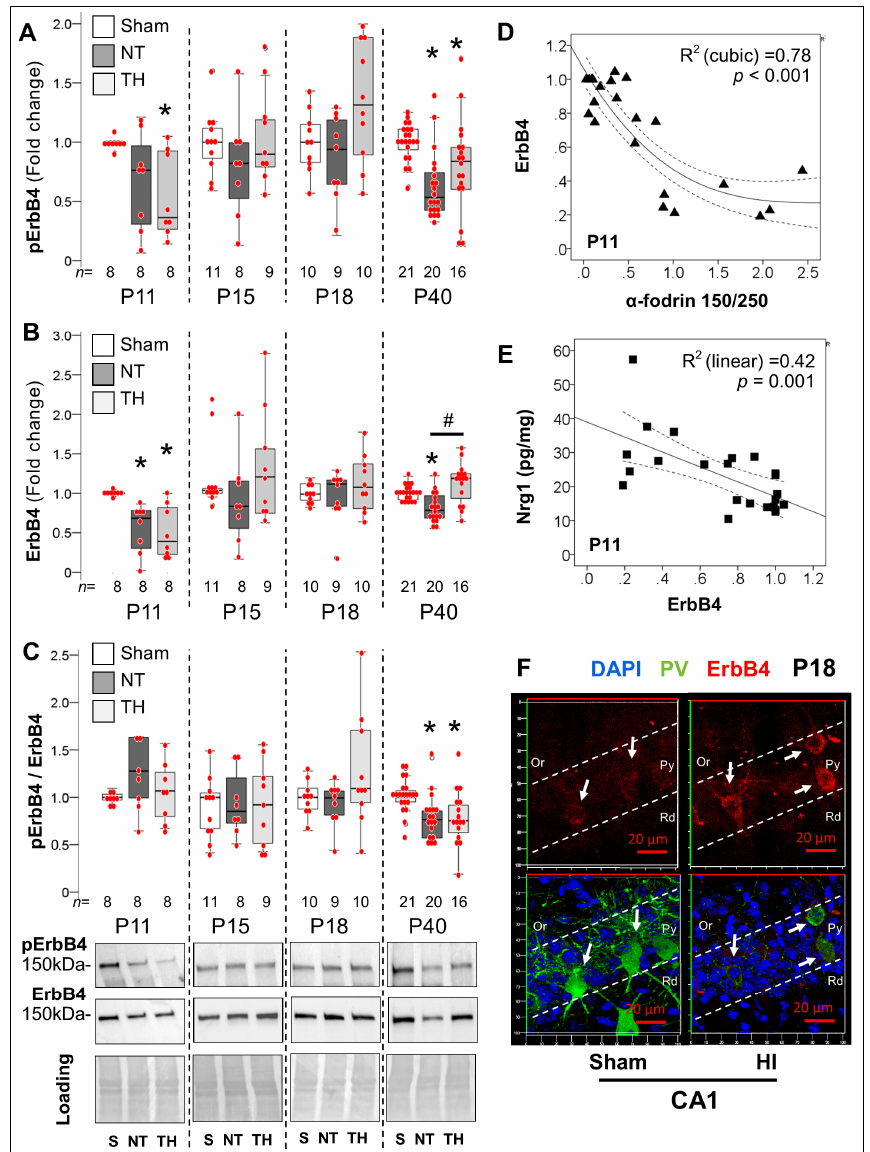
Figure 6. Acute and late deficits in ErbB4 receptor expression and activation after neonatal HI. ( A , B ) 24 h after HI ErbB4 phosphorylation (KW p = 0.04) and total expression (KW p = 0.001) decreased regardless of treatment with NT or TH. By P15 and P18, ErbB4 phosphorylation and total expression returned to levels similar to sham mice. Deficits remerged at P40 with a 43% ( p <0.001) and 22% ( p = 0.02) lower ErbB4 phosphorylation and total expression, respectively compared to sham (KW p < 0.001). TH prevented the decrease in total ErbB4 levels at P40 ( p <0.001 vs. NT mice) but not the decrease in phosphorylation. ( C ) HI injury resulted in lower ErbB4 phosphorylated to total ratio (KW p = 0.001) at P40, regardless of treatment with TH. Representative blots are shown for Y1162 phosphorylated and total ErbB4 at 150 kDa, and ponceau S as loading control. ( D ) Hippocampal 150 kDa α -fodrin BDP relative to 250 kDa protein strongly predicted the decrease in ErbB4 expression at P11(R 2 (cubic) 0.78, p < 0.001). ( E ) The decrease in ErbB4 expression linearly predicted the increase in Nrg1 24 h after HI (R 2 (linear) 0.42, p = 0.001). ( F ) The recovery in ErbB4 expression after HI at P15 and P18 coincided with the increased expression (red) on surviving PV + INs (green) in IF-IHC compared to sham. Quantifications are shown as hybrid box and whisker and vertical dot plots. *, p < 0.05 vs. sham; #, p < 0.05 vs. NT (Dunn-Bonferroni post-hoc test for Kruskal Wallis ANOVA; n shown under each